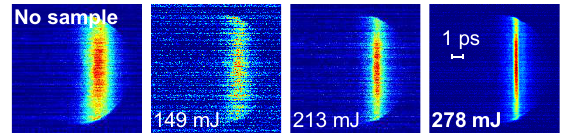
Fig. 4. Raw autocorrelation images of a pulse compressed in a KCl+BaF 2 (each 50 mm thick) post-compressor system at different